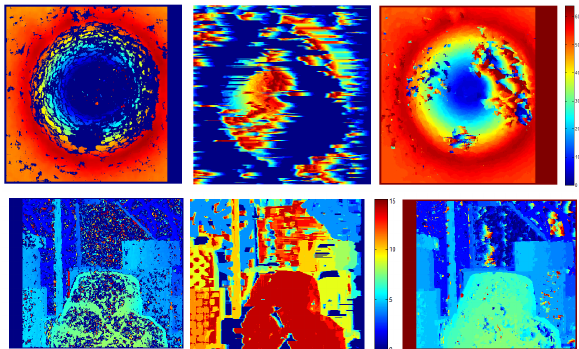
Figure 4: Disparities generated by (A) Blockmatching (B)